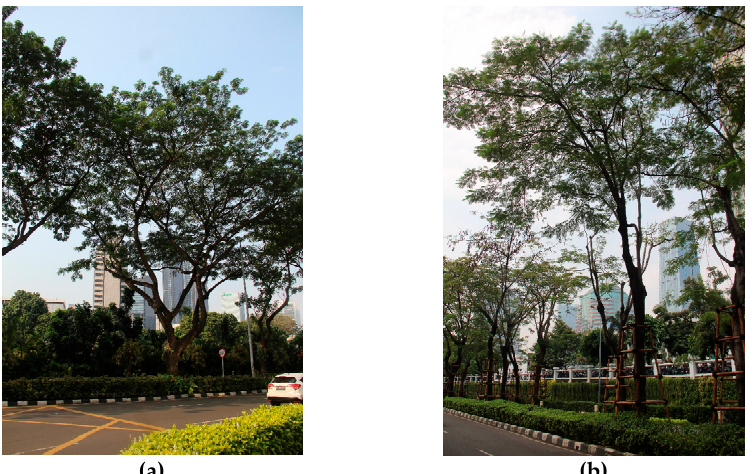
Figure 4. The example of tree appearance of ( a ) rain tree ( Samanea saman ) and ( b ) flamboyant tree ( Delonix regia ) in the urban